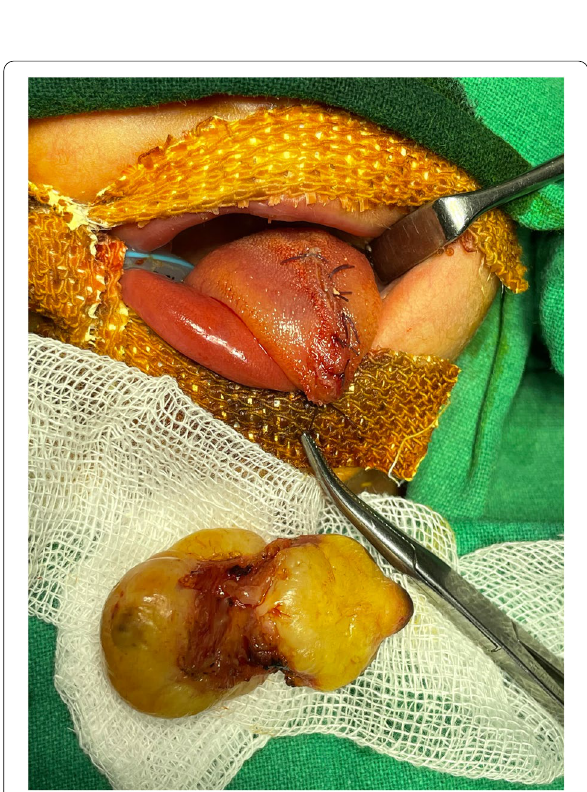
Fig. 4 Preoperative photo following reconstruction of the